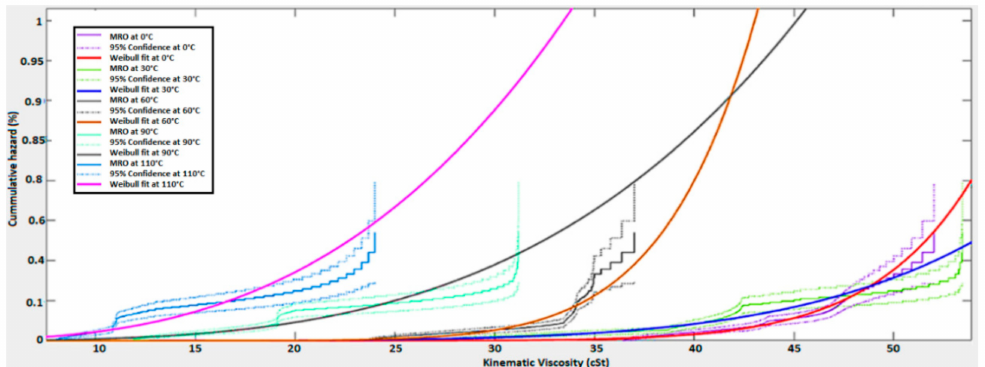
Figure 21. Cumulative hazard of MRO showing the data points of kinematic viscosity under varying concentration of Al 2 O 3 in different temperature levels.